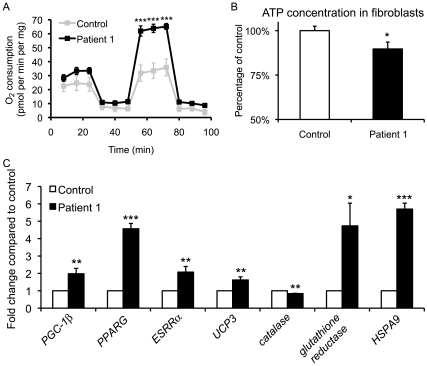
Human MADD fibroblast cells display similar mitochondrial defects as xav mutants.
A. Oxygen consumption was measured in intact control and MADD Patient 1 fibroblasts under basal conditions, following the addition of the mitochondrial ATP synthase inhibitor oligomycin (0.5 µg/ml), in the presence of the uncoupler CICCP (3 µM) to maximally stimulate respiration and following the addition of complex I inhibitor rotenone (100 nM) to assess residual non-mitochondrial oxygen consumption. A 2-fold increase was observed in Patient 1 fibroblasts compared to control, after uncoupler CICCP treatment, which measures the maximal uncontrolled mitochondrial respiratory capacity (N = 3 experiments, 7–9 replicates of cells from passage 7–12; Student's t test, *** p<0.001). B. Measurement of ATP levels showed a ca. 10% reduction in MADD Patient 1 fibroblast cells compared to control (N = 14 replicates of cells from passage 7–12; Student's t test, * p<0.05). C. Gene expression assayed by qRT-PCR revealed that PGC-1β, PPARG, ESRRα, UCP3 were increased ∼2, 4.6, 2 and 1.6 fold in Patient 1 compared to control. The expression of ROS related genes are also altered in Patient 1, with a ca. 20% decrease in catalase and 4.7 and 5.7 fold increase in glutathione reductase and HSPA9 expression (N = 3–7 replicates of cells from passage 7–12; Student's t test, * p<0.05, ** p<0.01, *** p<0.001).